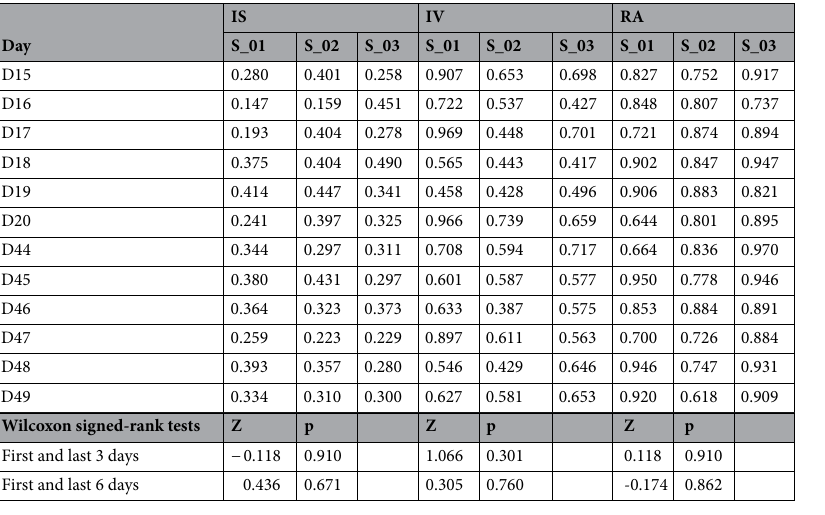
Table 1. The comparison of IS, IV, and RA at the beginning (D15-D20) and terminal (D44-D49) of the